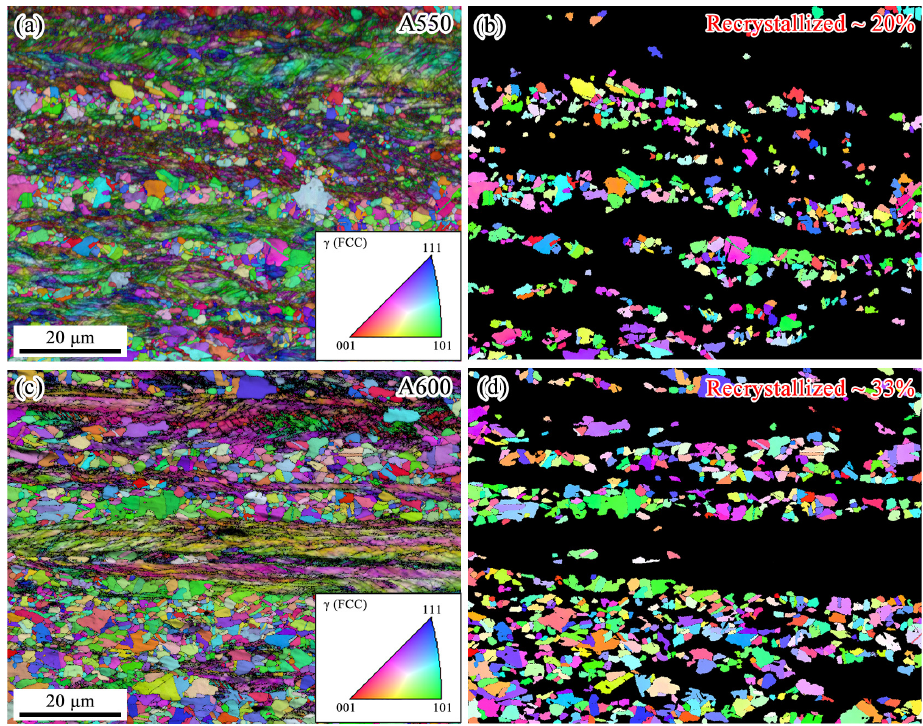
Figure 2. EBSD inverse-pole-figure (IPF)+ image-quality (IQ) maps and corresponding recrystallization IPF maps of ( a , b ) A550 and ( c , d ) A600 specimens, respectively.